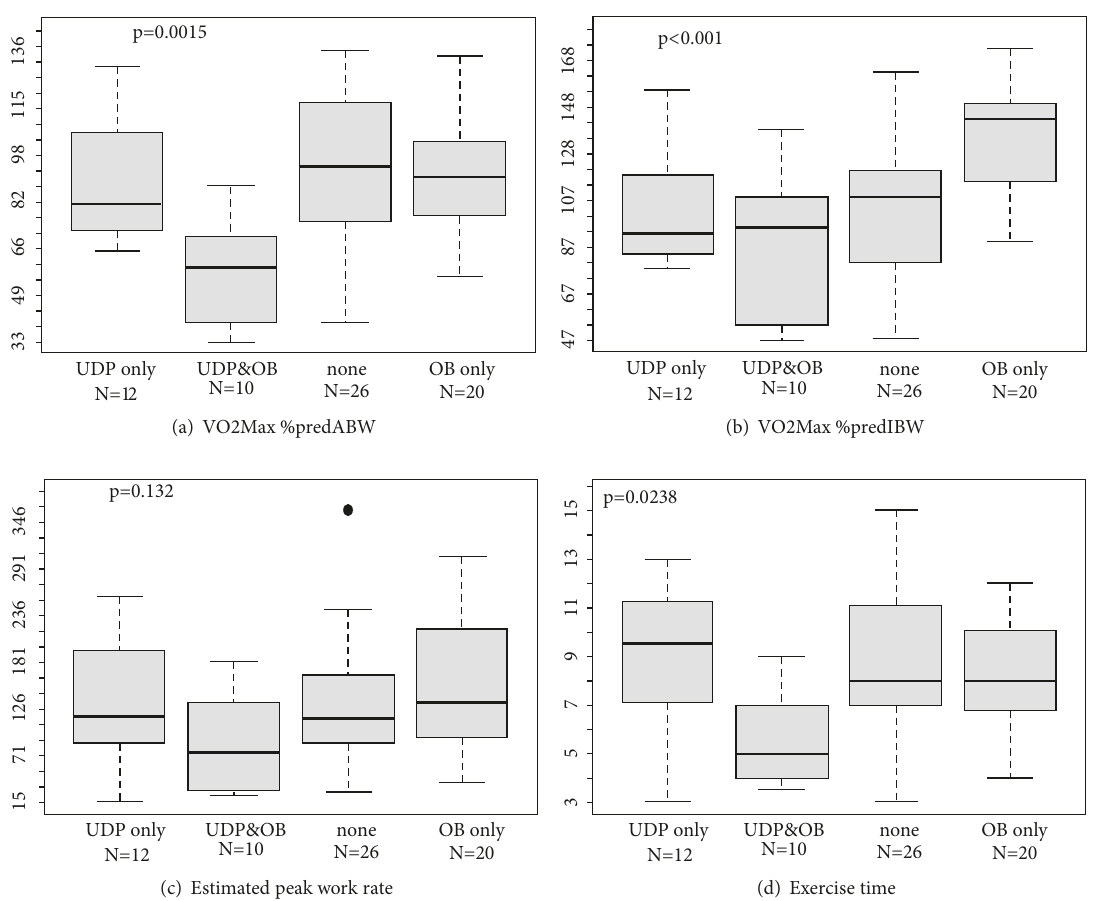
Figure 2: CPET parameters in matched UDP and non-UDP subjects, with and without obesity. Box plot showing the interquartile range, median, min, max, and possible outliers. UDP= unilateral diaphragm paralysis; OB= obesity. Outliers are indicated as dots on the figure. p-values based on stratified linear regression. Panel (a): VO2 at peak exercise, as percent predicted referenced to actual body weight. Panel (b): VO2 at peak exercise, as percent predicted referenced to ideal body weight. Panel (c): (PWR, watts) = 9.81(m ∗ v ∗ i)/100, where m is mass (kg); v is velocity (m/sec); i is treadmill %incline. Panel (d): total exercise time,